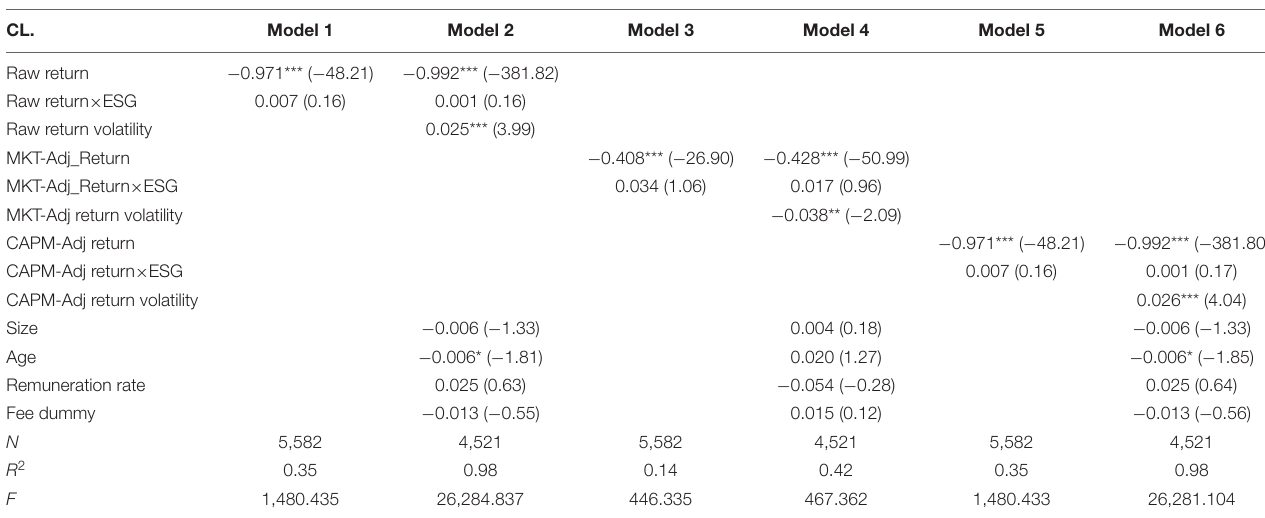
Table 3 is the result of regression (OLS) analysis on the sensitivity of fund flow–fund characteristics. The dependent variable is fund flow. Raw return is the average of returns over the previous 12 months; MKT-Adj return, the market-adjusted returns over the previous 12 months; CAPM-Adj return, CAPM-adjusted return over the previous 12 months; Raw return volatility, the volatility of raw return over the previous 12 months; MKT-Adj return volatility, the volatility of the market-adjusted returns over the previous 12 months; CAPM-Adj return volatility, the volatility of CAPM-adjusted returns over the previous 12 months; ESG, a dummy that shows whether it is an ESG fund; Size, the natural logarithm of the size of the assets operated by the fund; Age, the age; Remuneration rate, the natural logarithm of a fee; and Fee dummy, the front-end fee dummy. The content of the table is the regression coefficient value; the figure in parentheses, t-value; and ***, **, and * means that each is significant, respectively, at 1, 5, and